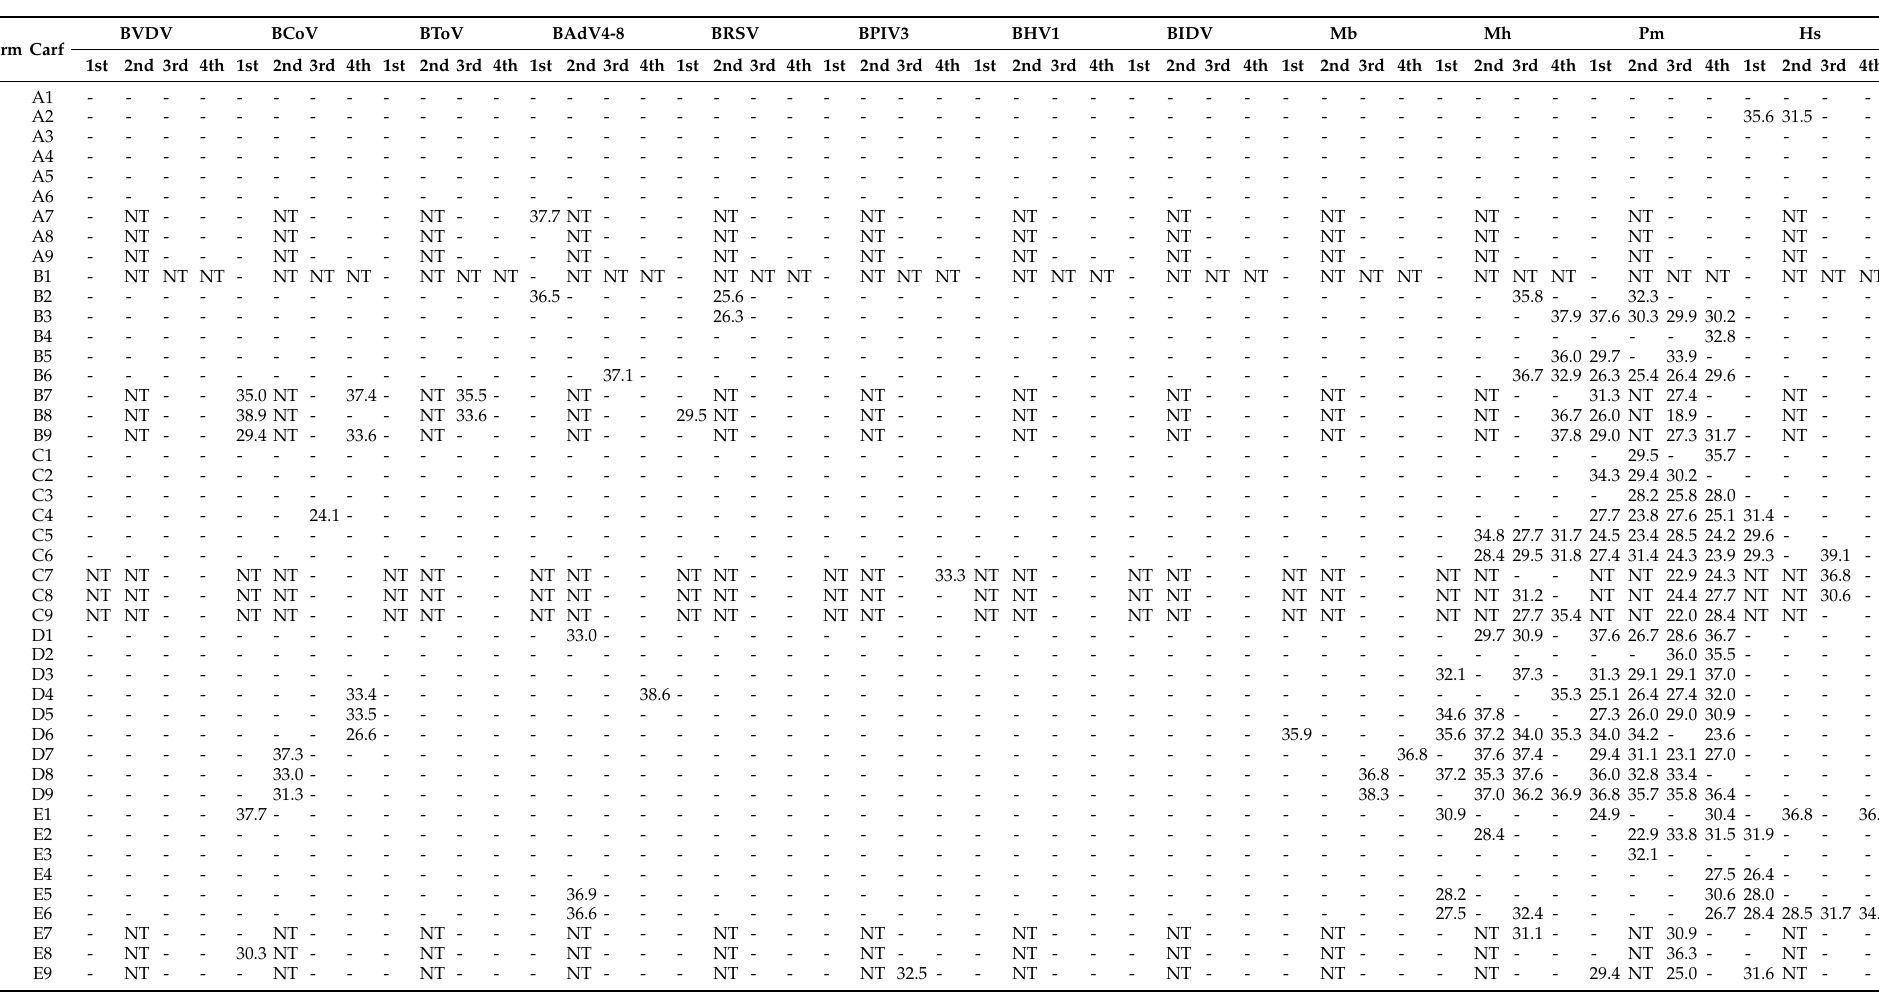
Table 1. Summary of Ct values of bovine respiratory disease-associated 12 pathogens using 232 nasal swabs from 63 clinically healthy calves by multiplex real-time